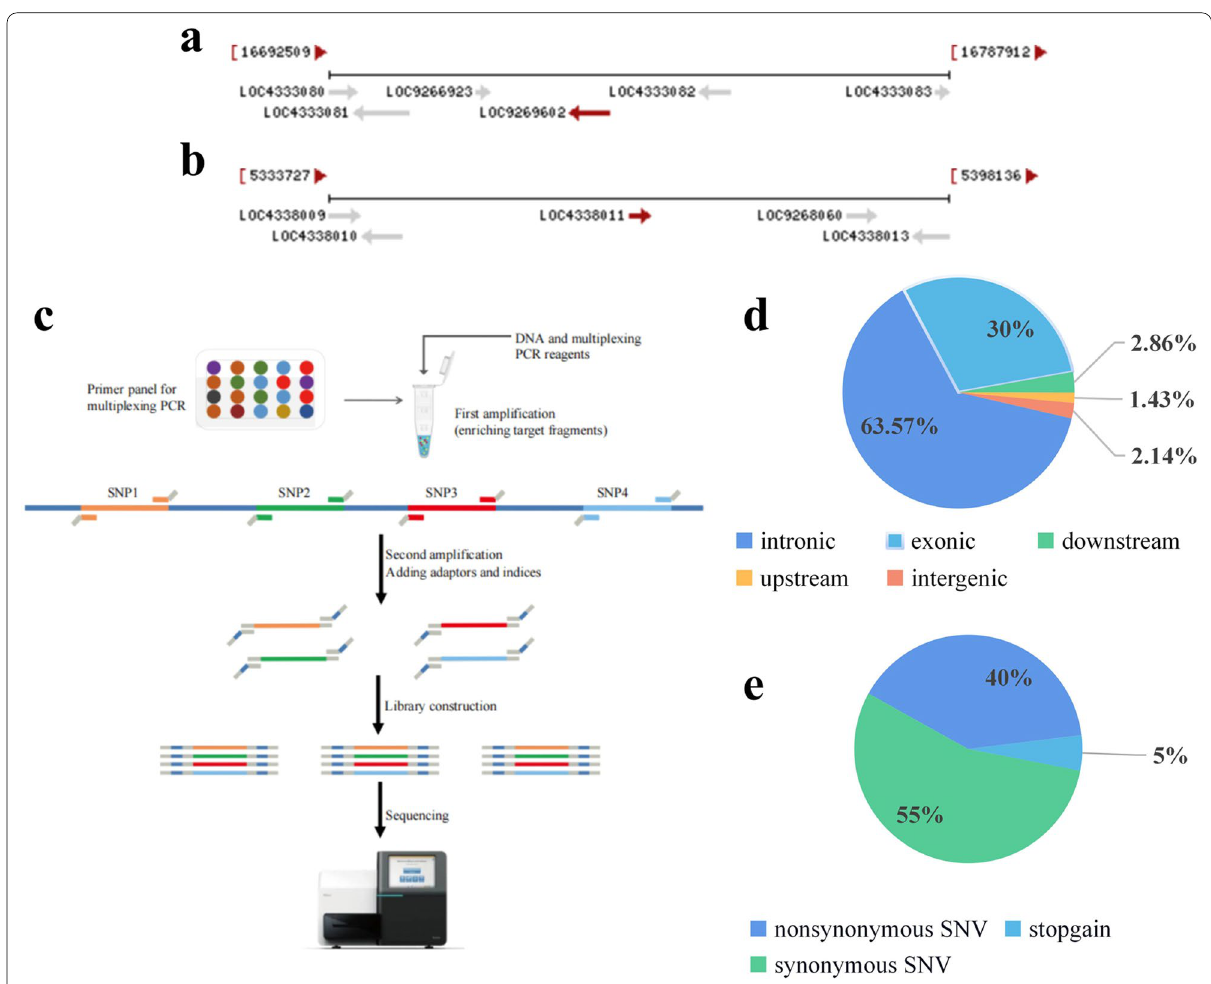
Fig. 3 a GS3 gene information. b GW5 genetic information. c Targeted sequencing process. d Location distribution of SNPs in the genome. e Mutation site functional type